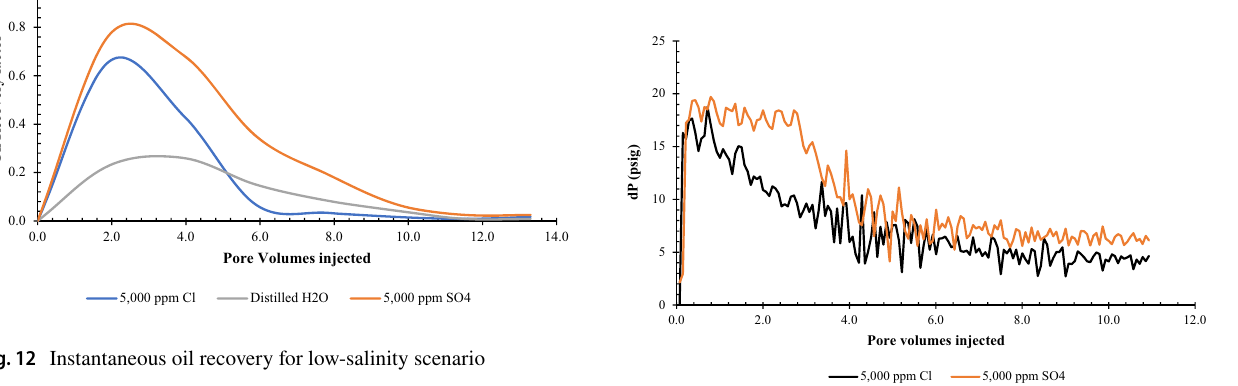
Fig. 12 Instantaneous oil recovery for low-salinity scenario